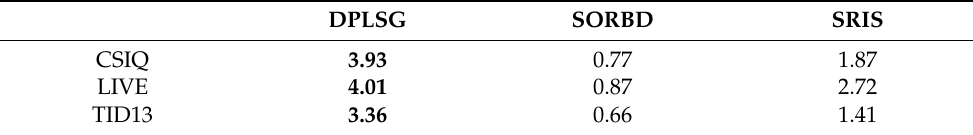
Table 5. Average time cost per image on salient region detection (seconds).